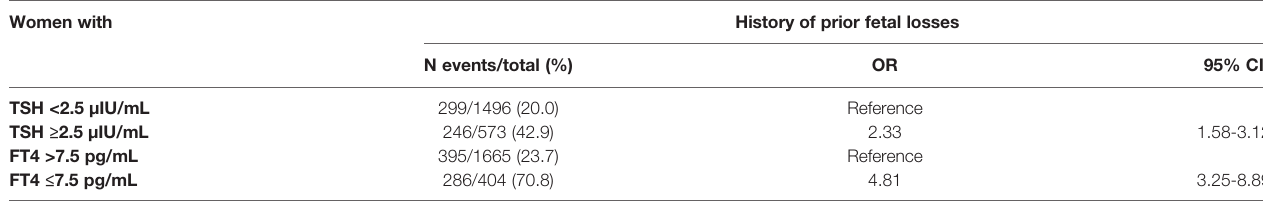
TABLE 2 | Odds ratio (95% con fi dence interval) for a history of prior fetal losses adjusted for age, parity, and smoking habit in women from Study 1